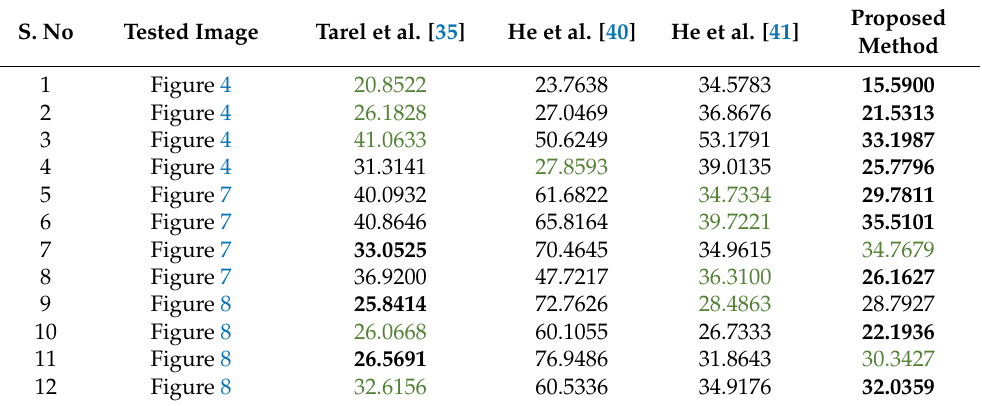
Table 1. Quantitative comparison of different methods based on PIQE evaluation.